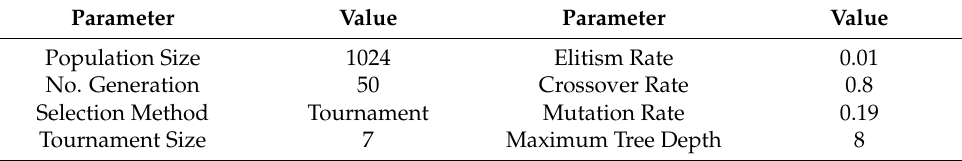
Table 1. The necessary GP parameter settings.